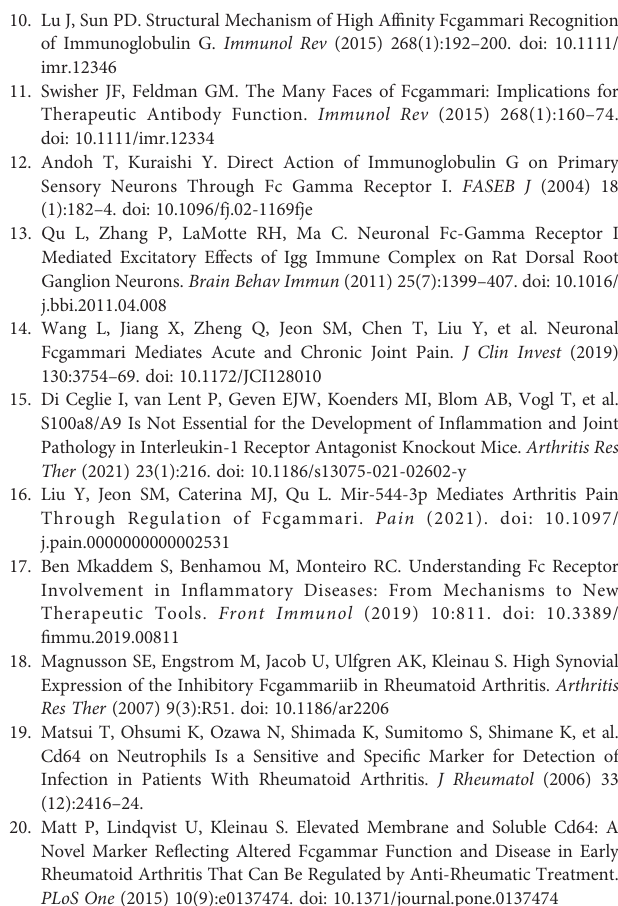
Supplementary Figure 1 | Pirt mRNA expression is downregulated in the DRG in the posin fl ammatory phase of CAIA. qPCR analysis of Pirt mRNA expression in L3- L5 DRGs of control (Ctrl) and CAIA mice on days 56 after immunization. n = 8 mice per group. p < 0.01 versus Ctrl, unpaired Student ’ s